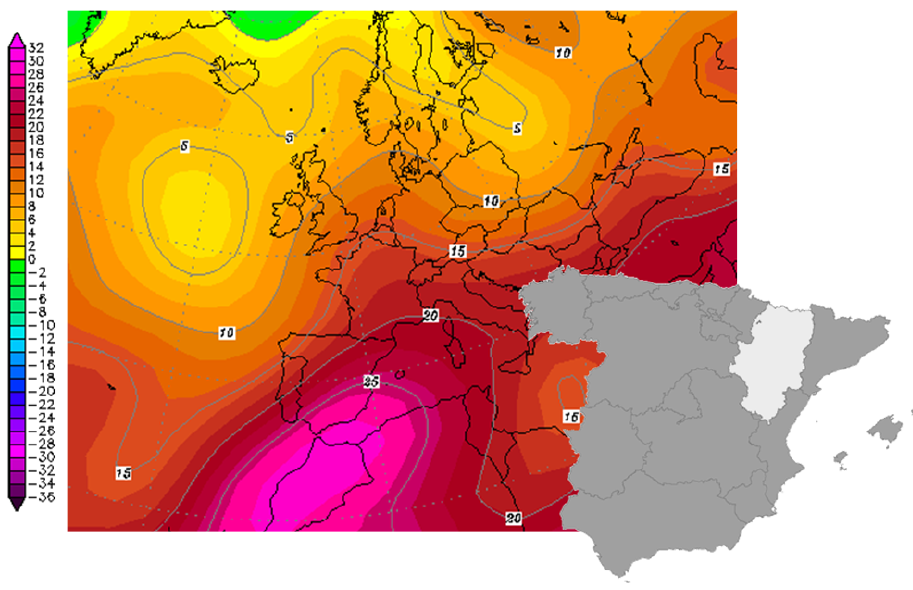
Fig. 1. Geographic location of Arag´on and air temperature at 850hPa (legend in ◦ C) for 2 July 1994. Source: